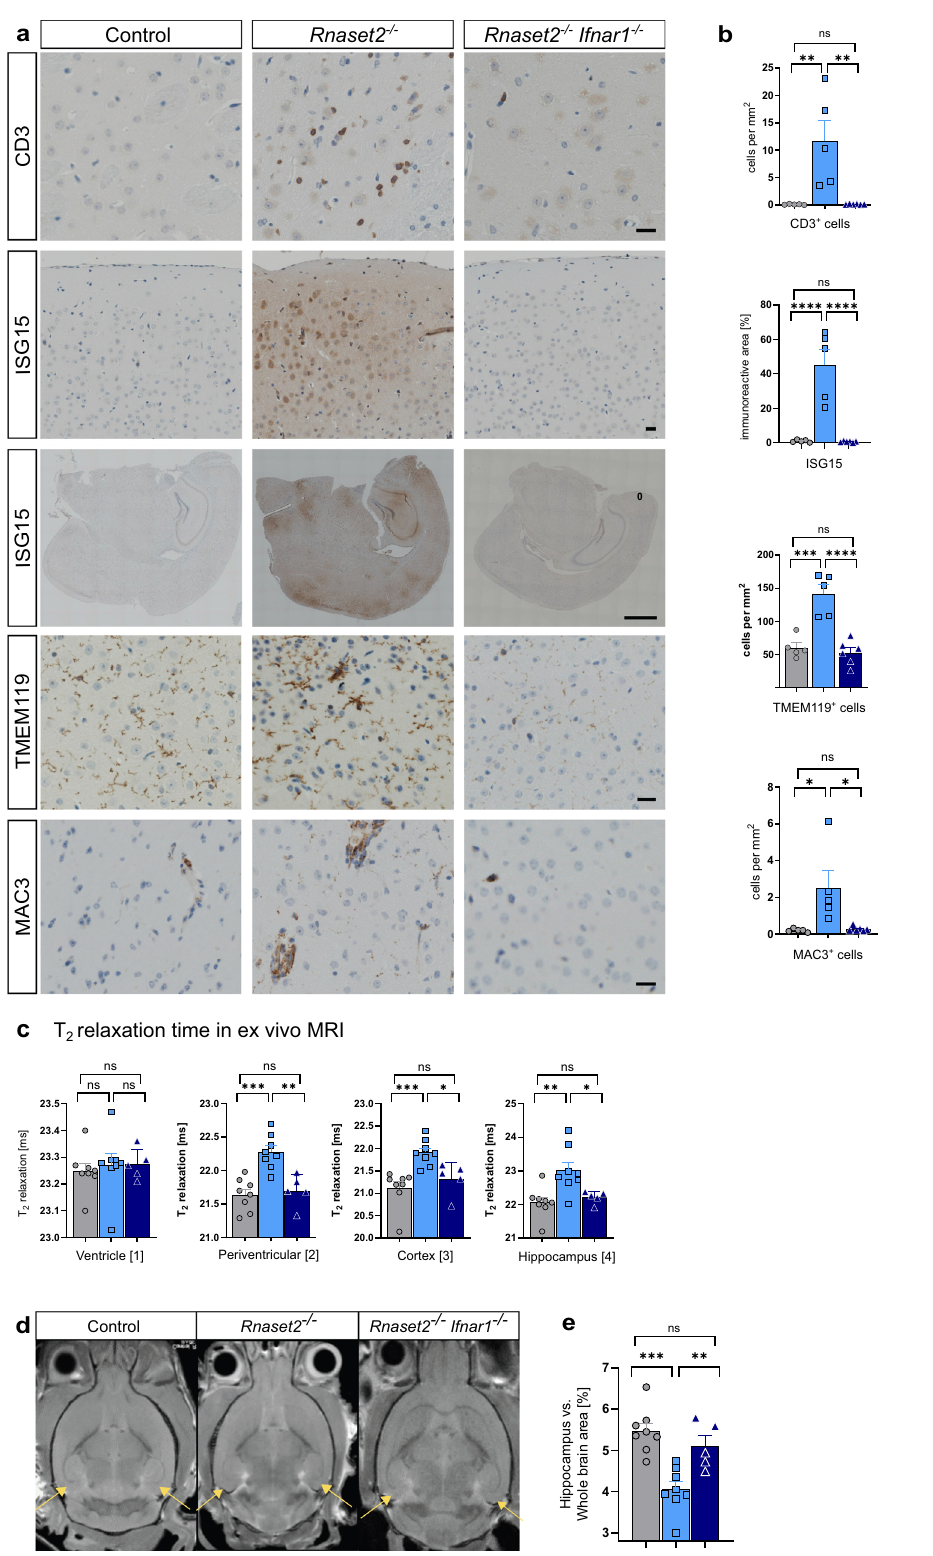
centrifugation, the supernatant was dried and proteins were denatured by boiling in Tris-Glycine SDS sample buffer and separated by SDS-PAGE using 4 – 20% Tris- Glycine Gel (NovexTM, Thermo Fisher Scienti fi c). 300ng bovine serum albumin (BSA) was loaded as standard control and 10µl molecular marker (Pro Sieve Quad Proteinmarker 4.6 – 300kDa, Biozym Scienti fi c) was used. The bone marrow from Rnaset2 − / − and control mice was isolated after cardiac arrest from the femur. In brief, the femur was segregated from the mouse